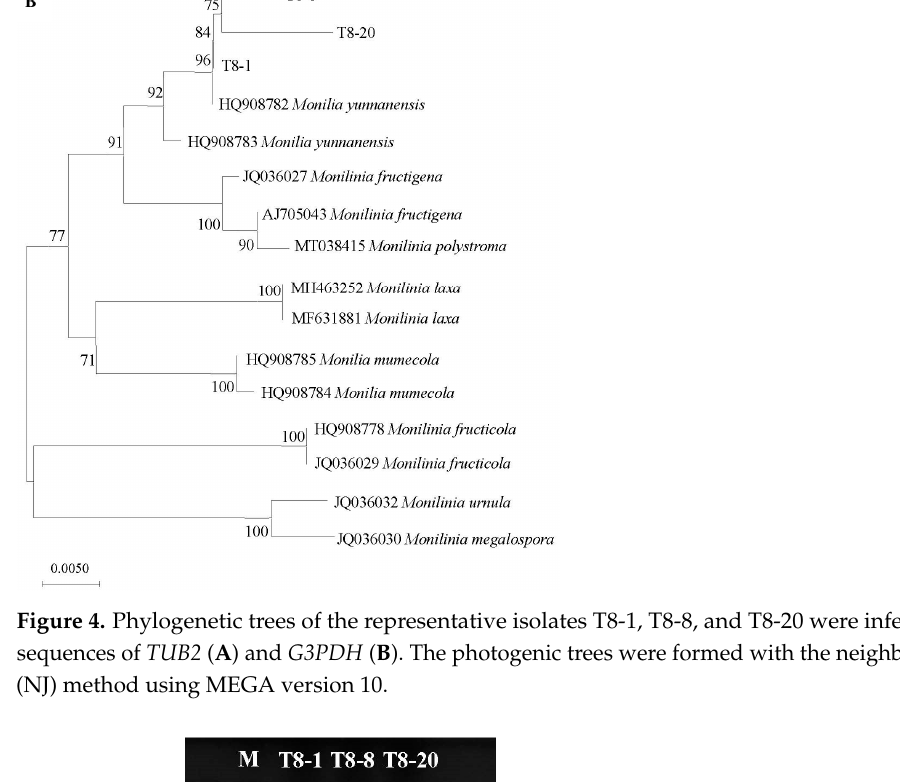
Figure 5. Multiplex polymerase chain reaction (PCR) results for the representative isolates T8-1, T8-8, and T8-20. Lane M, marker.